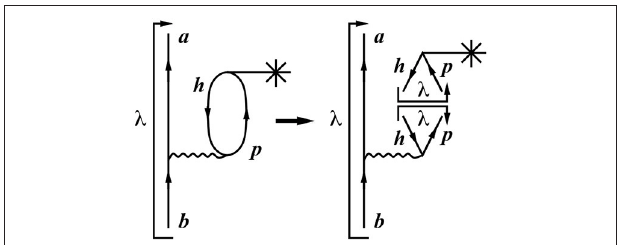
Explicitly, we can evaluate the diagram